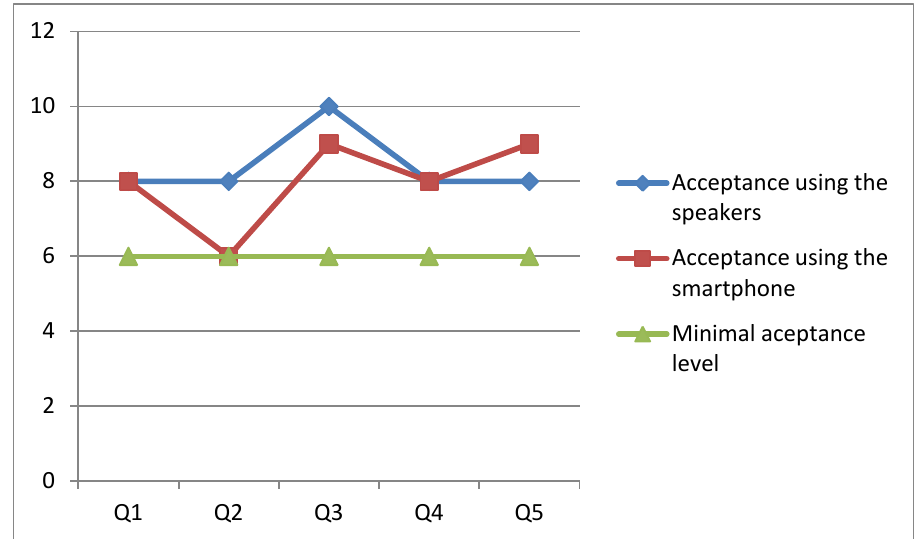
Figure 12. Median of the experimental results with and without a